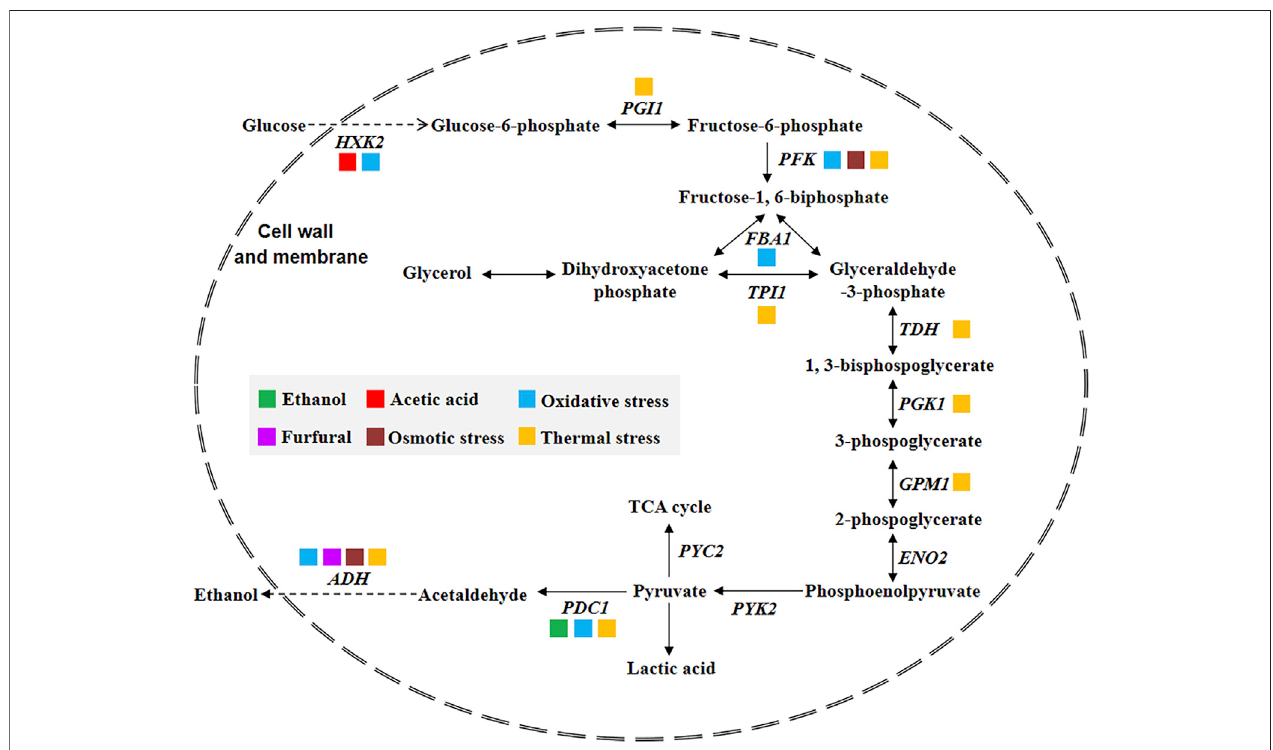
FIGURE 2 | Schematics of stress-associated genes involved in the glycolysis pathway for ethanol production of S. cerevisiae . Colorful solid-squares represent identi fi edstresstolerances ofgenes( HXK ,hexokinase; PGI , phosphoglucoisomerase; PFK ,phosphofructokinase; FBA , fructose1,6-bisphosphate aldolase; TPI , triose phosphate isomerase; TDH , glyceraldehydes-3-phosphate dehydrogenase; PGK , 3-phosphoglycerate kinase; GPM , phosphoglyceromutase; ENO , enolase; PYK , pyruvate kinase; PYC , pyruvate carboxylase; PDC , pyruvate decarboxylase; ADH , alcohol dehydrogenase).